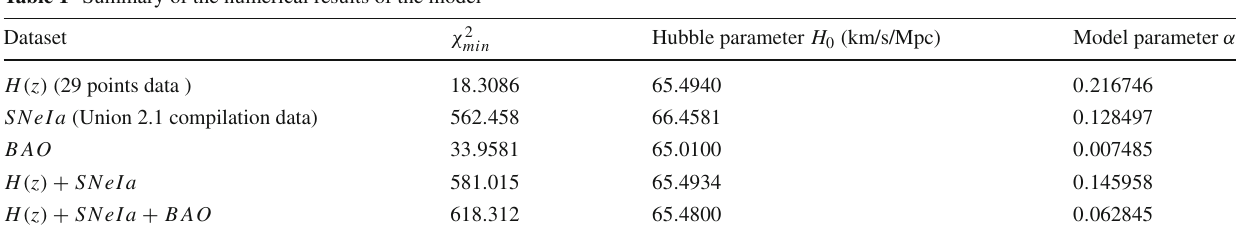
Table 1 Summary of the numerical results of the model Dataset χ 2